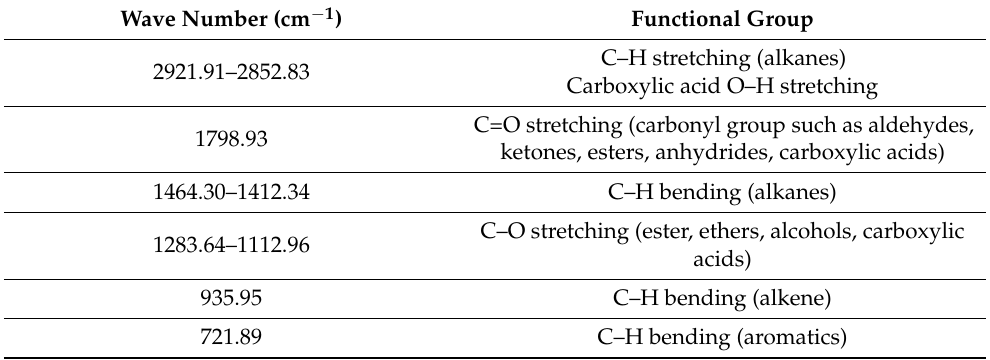
Table 2. The FT–IR functional group of WCO.